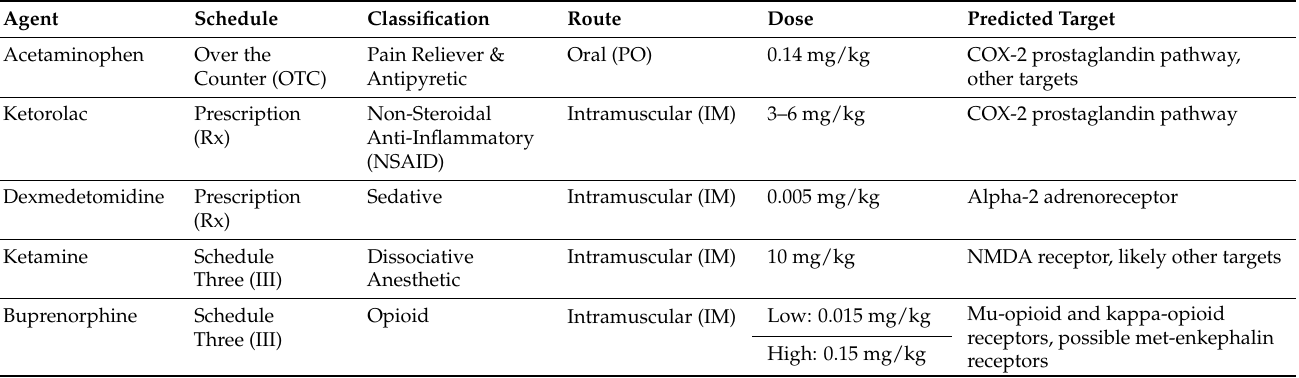
Table 2. Candidate analgesic drugs tested for efficacy in E. berryi , their dosages and their administra- tion